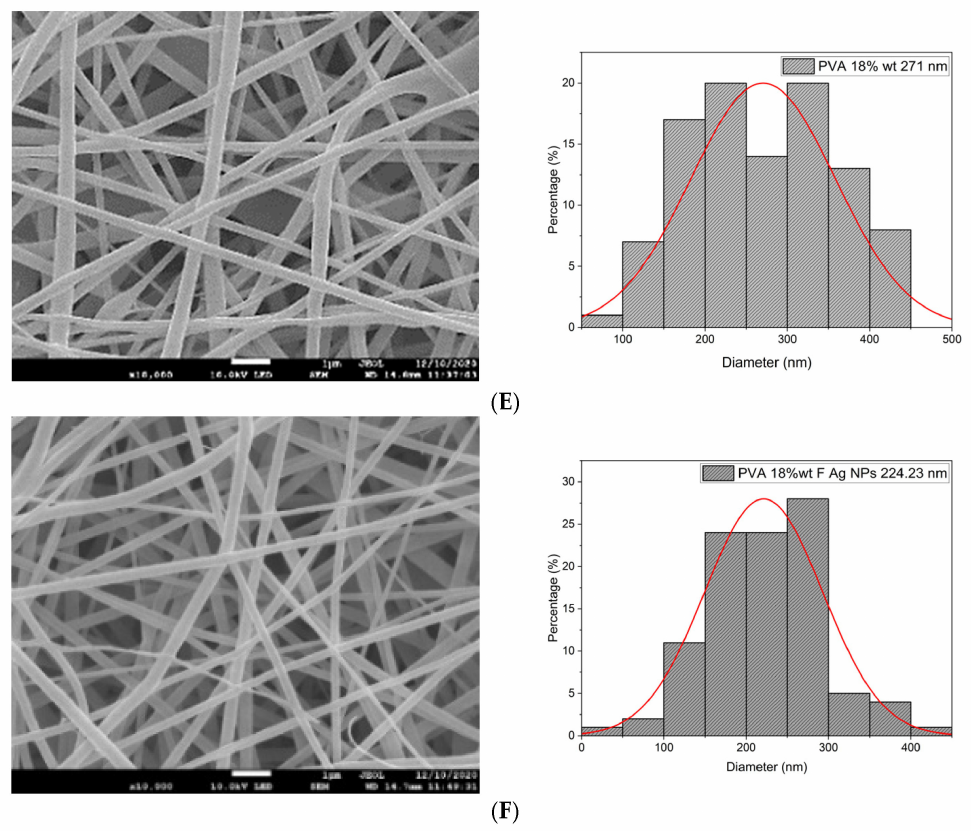
Figure 4. SEM images and average nanofiber diameter histograms of the ( A ) PVA 10% wt, ( B ) PVA10/SF/Ag-NPs, ( C ) PVA 15% wt, ( D ) PVA15/SF/Ag-NPs, ( E ) PVA 18% wt, and ( F )